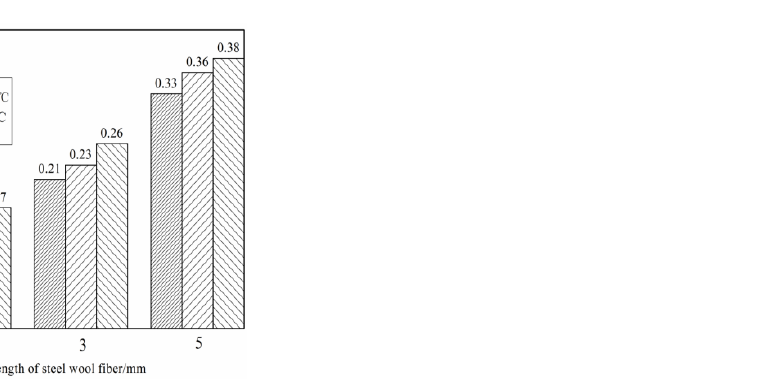
°C; ( c ) −5 °C . ( b ) − 10 ◦ C; ( c ) − 5 ◦ C. Figure 14. The influence of lengths of steel wool fiber and ambient temperature on deicing temperature. ( a ) −15 °C; ( b ) −10